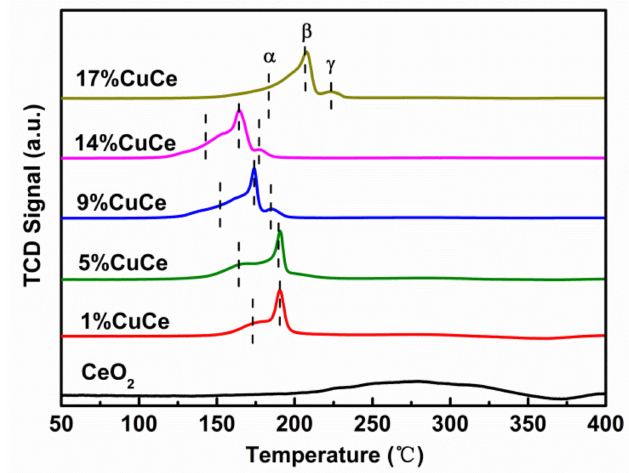
Figure 5. Hydrogen-temperature programmed reduction (H 2 -TPR) profile of the prepared